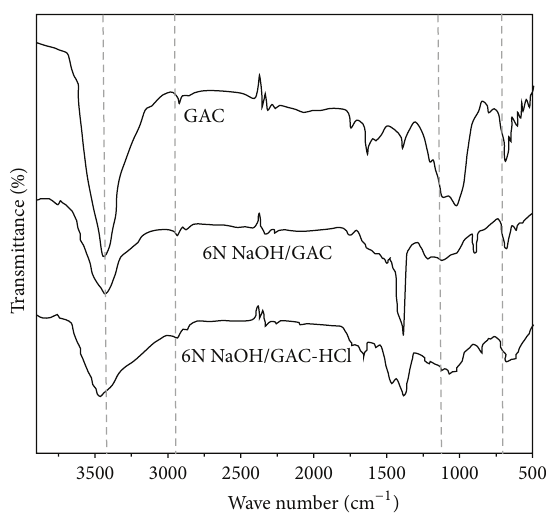
Figure 4: FTIR spectrum of GAC and modified